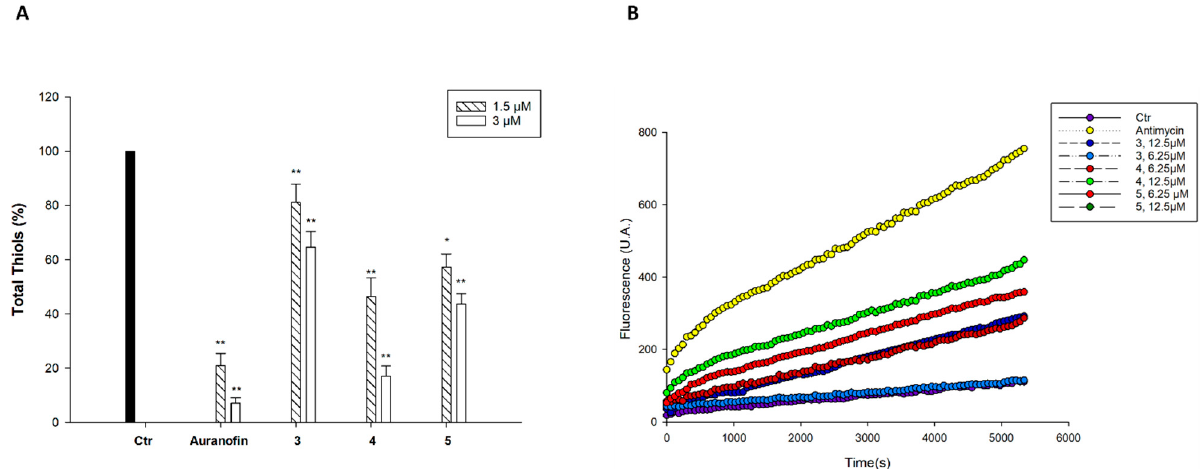
Figure 3. Effects on sulfhydryl content and ROS production. ( A ) Sulfhydryl content in U1285-treated cancer cells incubated for 24 h with tested compounds. The sulfhydryl group amount was determined by the DTNB assay. Error bars indicate S.D. * p < 0.05, ** p < 0.01. ( B ) Effect of silver(I) compounds on hydrogen peroxide formation in U1285 cells. Cells were pre-incubated in PBS/10 mM glucose medium for 20 min at 37 ◦ C in the presence of 10 µ M CM–DCFDA and then treated with increasing concentrations of the tested compounds.